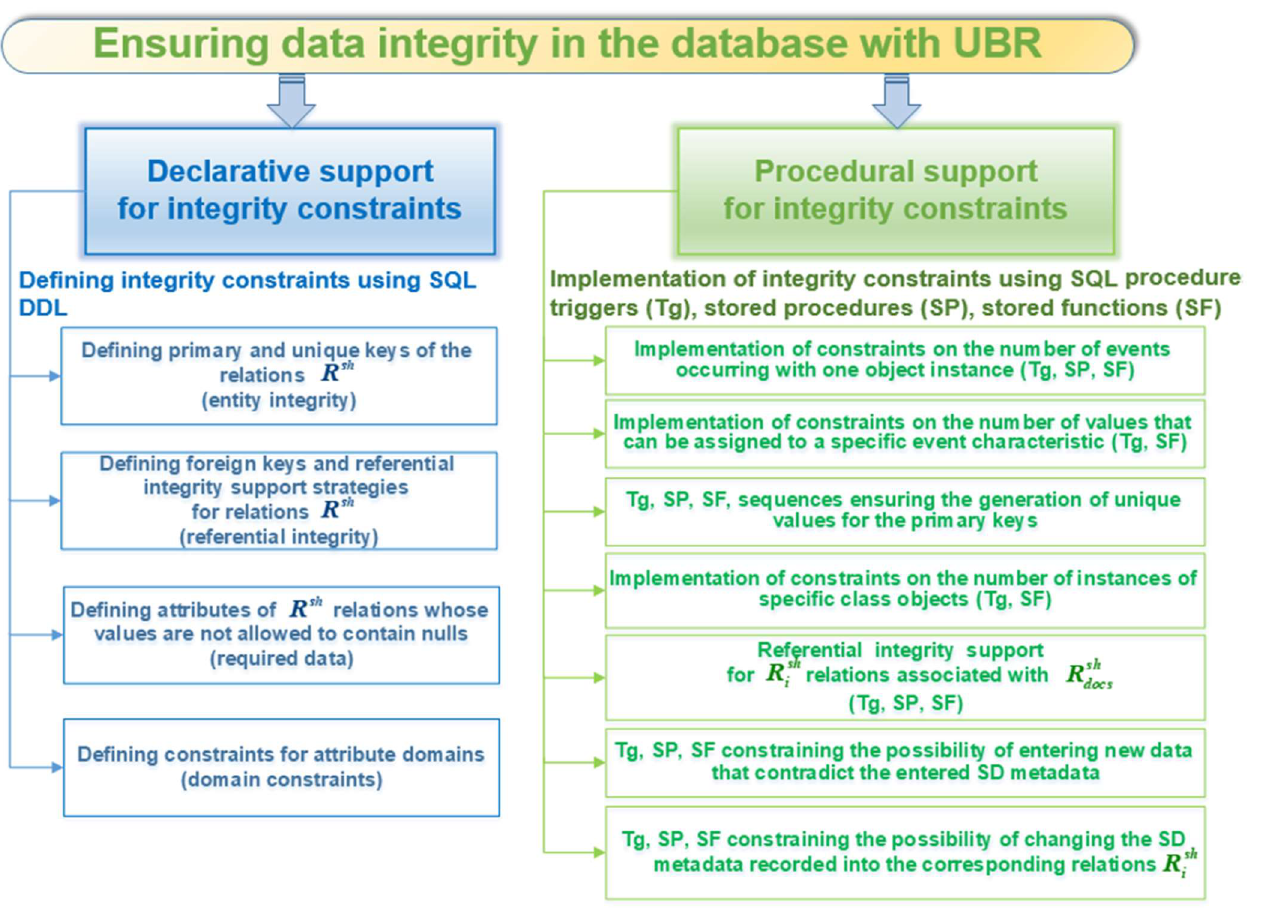
Figure 3. Scheme of using techniques of declarative and procedural support for integrity constraints to ensure data integrity in the DB with